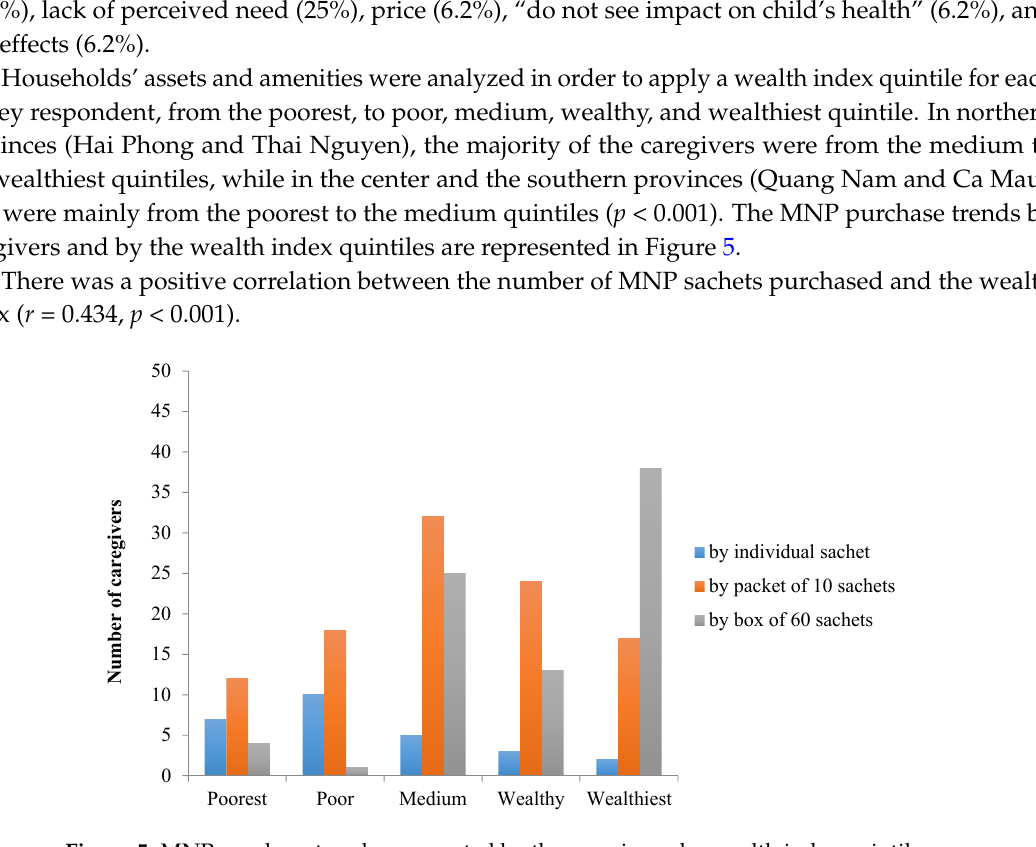
Figure 5. MNP purchase trends as reported by the caregivers, by wealth index quintiles.